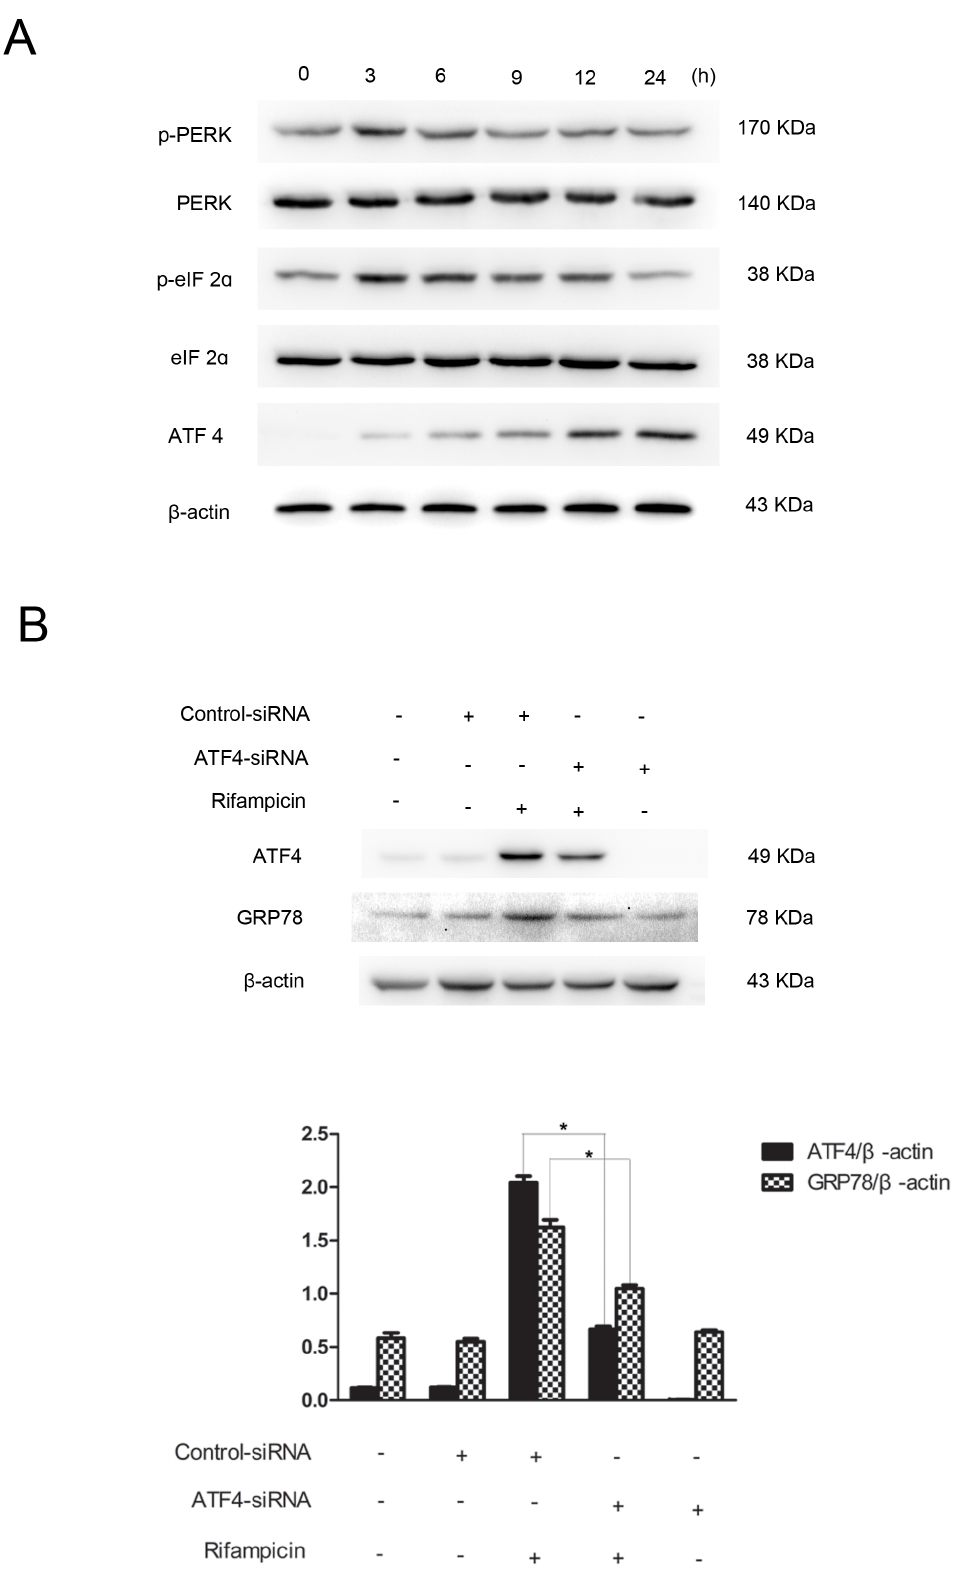
Figure 4. The PERK-eIF2 a -ATF4 pathway regulated rifampicin-induced GRP78 activation. (A) PC12 cells were treated with 150 m M rifampicin for indicated lengths of time, ranging from 3 to 24 h. Cell lysates were analyzed by western blotting using antibodies against phosphorylated PERK (p-PERK), PERK, phosphorylated eIF2a (p- eIF2a), eIF2a, ATF4 and b -actin. Rifampicin induced a transient PERK phosphorylation at 3 h post-incubation. eIF2a was activated at 3 h post-treatment, which persisted for 9 h and started to decline thereafter. ATF4 was activated at 6 h